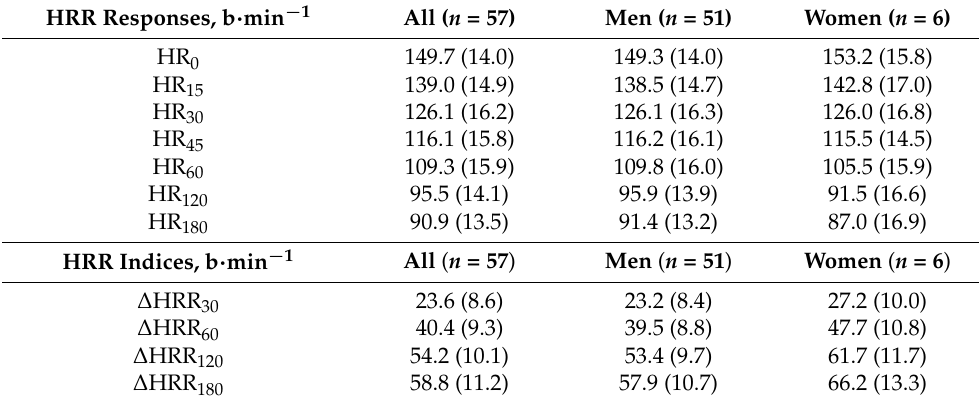
Table 2. Descriptive HRR data, mean (SD).